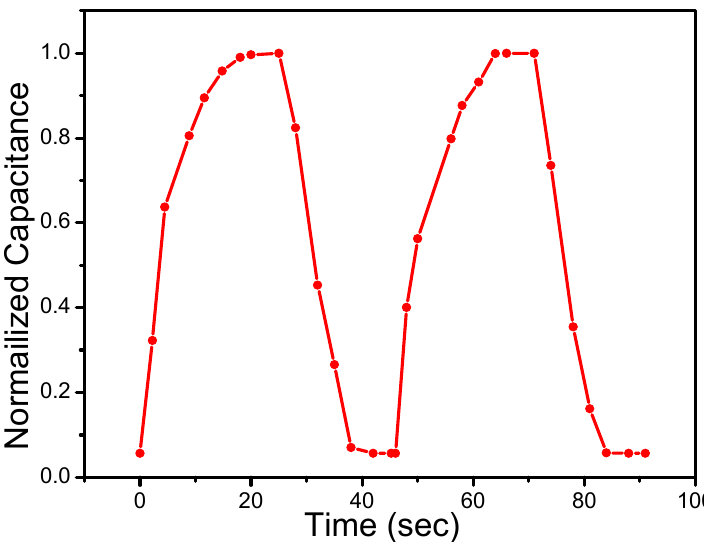
Figure 8. Response and recovery time (40% RH-97% RH level) of the O-PEPC-NiPC/Ag humidity sensors at 100 Ag/Cu 2